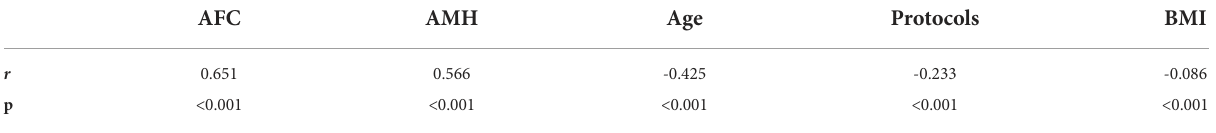
TABLE 3 The correlation between the number of retrieved oocytes and different in fl uence factors by Spearman